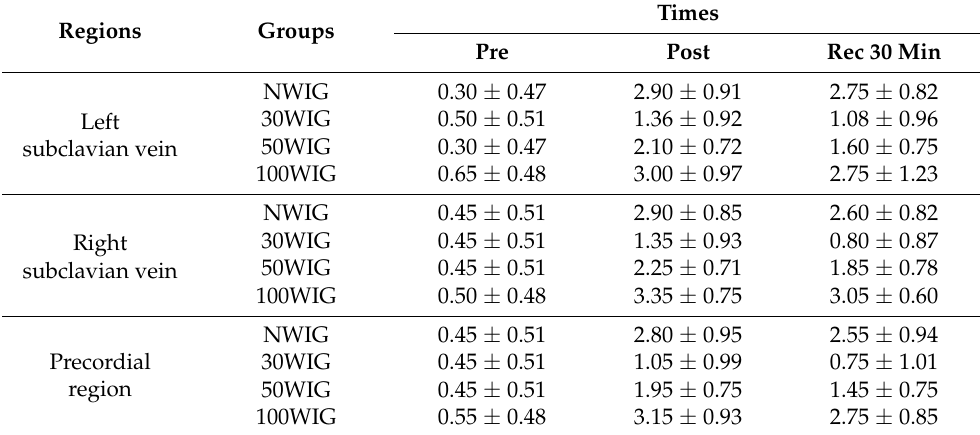
Table 5. Amplitude* in the left and right subclavian veins and precordial region. Regions